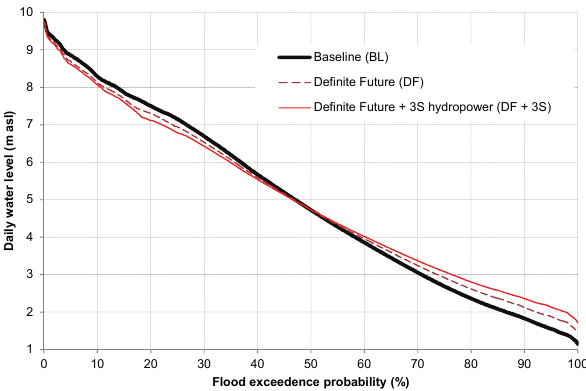
Figure 6. Exceedance probability plot of daily water levels. The greatest deviations are expected for water levels near the 20% ex- ceedance level ( ∼ 7ma.s.l.) and below the 70% exceedance level (less than